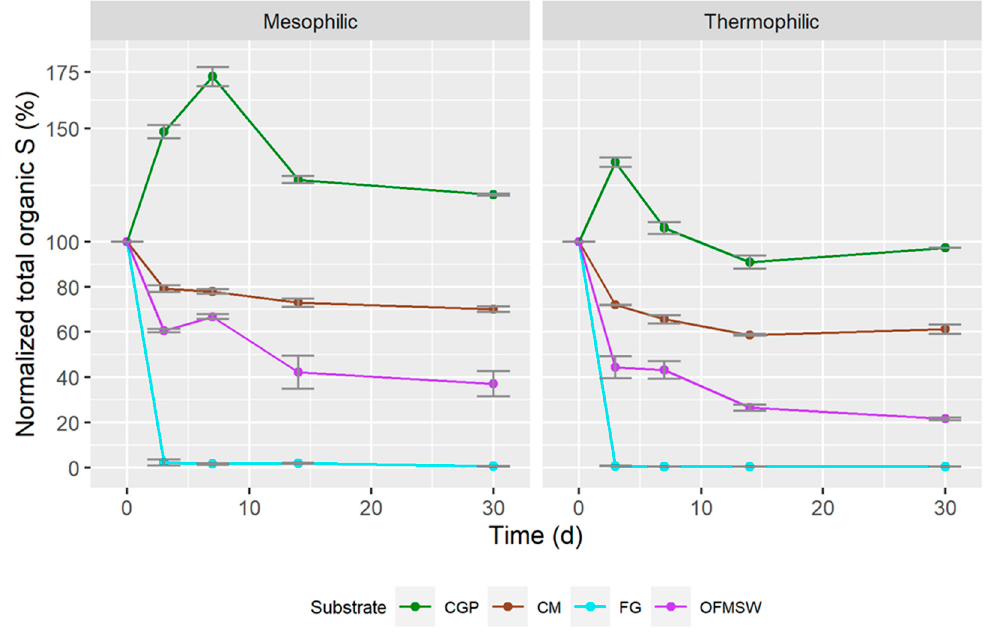
Figure 6. Total S remaining in Dacron bags over time in continuous experiment. Two different conditions (mesophilic, left and thermophilic, right) are shown with four different substrates. Error bars show standard deviation ( n = 3).